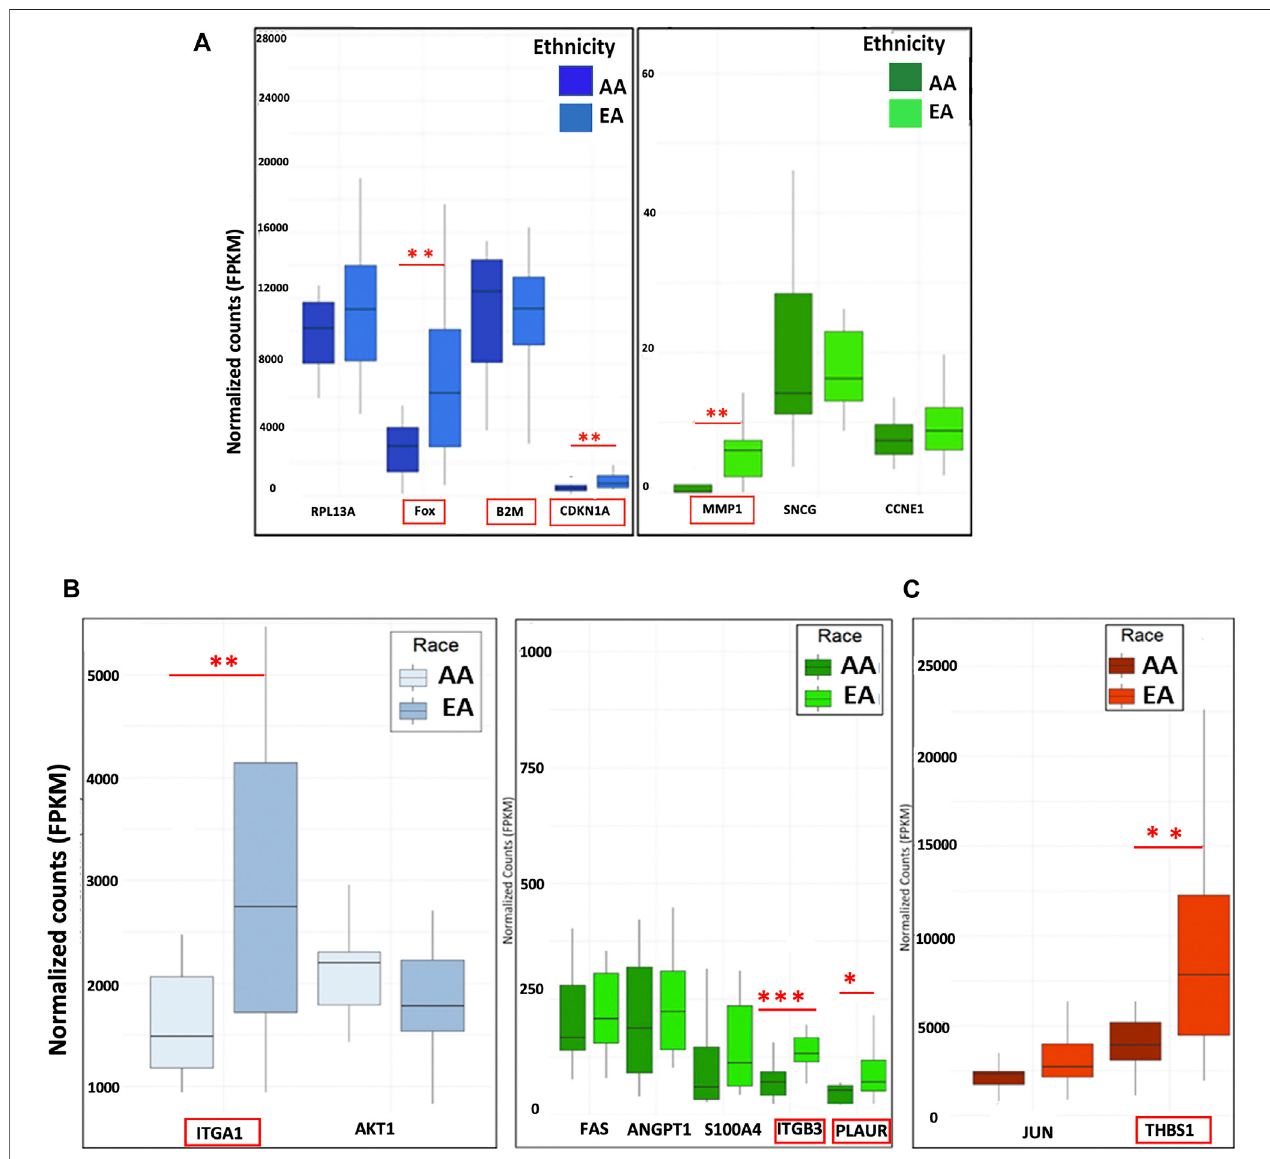
FIGURE 4 | Correlation of METRO-TOPO gene expression signatures in the PCa patient cohort. (A) Top DEGs for METRO-TOPO dosing were also differentially expressed inprostatecancerpatient cohort ( p * (cid:1) p ≤ 0.05, ** (cid:1) p ≤ 0.01, *** (cid:1) p ≤ 0.001).FOS, CDKNA1 and MMP1 expression islower inAA patients comparedtoEA patients, whereas B2M expression showed trends of higher expression in AA patients compared to EA patients. (B) METRO-TOPO genes unique to AI-mCRPC ( p * (cid:1) p ≤ 0.05,** (cid:1) p ≤ 0.01,*** (cid:1) p ≤ 0.001).ExpressionofITGA1,ITGB3andPLAURwaslowerinAAcomparedtoEApatients,whereasPLAURexpressionwashigher inAApatients.C)METRO-TOPOgenesignatureuniquetocastration-sensitivePCa(** (cid:1) p ≤ 0.01).THBS1expressionwaslowerinAAcomparedtoEApatients(FPKMis the Fragments Per Kilobase of transcript per Million mapped reads. In RNA-Seq, the relative expression of a transcript is proportional to the number of cDNA fragments that originate from the gene.